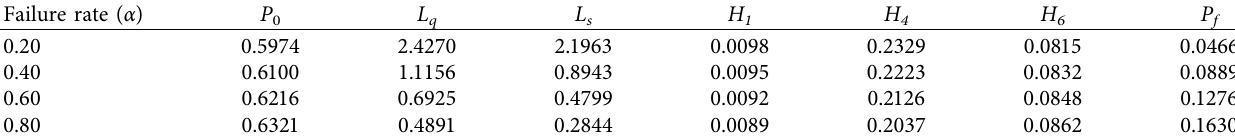
Table 6: The impact of failure rate ( α ) for various values of λ